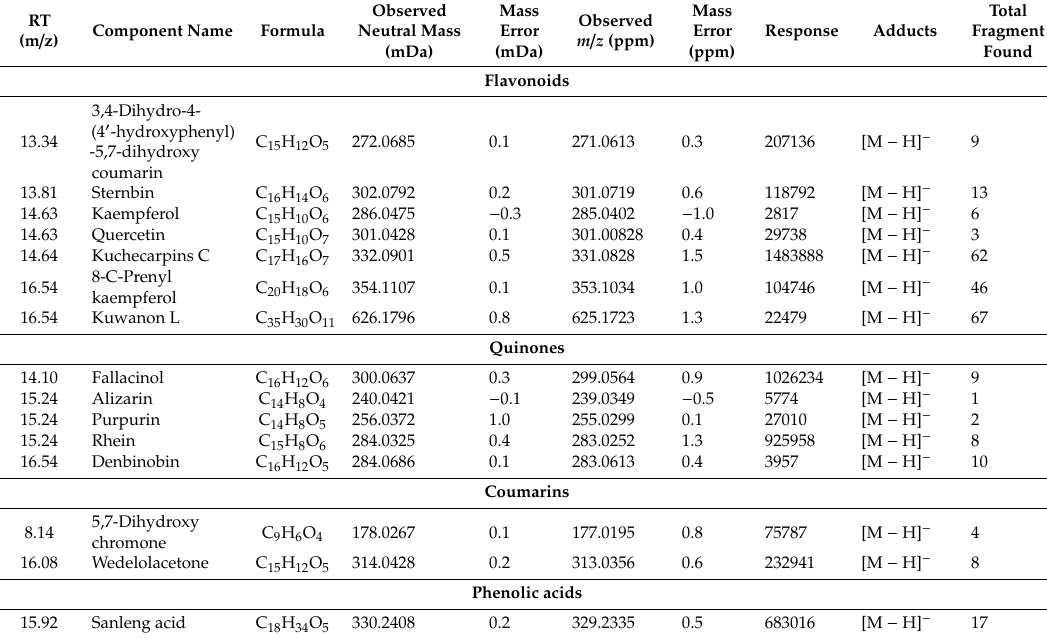
Figure 5. LC-chromatogram in negative ion mode for BPI plot of ethyl acetate root extract F3. Table 3. Tentative assigned phytocompounds in the F3 fraction of C. vespertilionis .